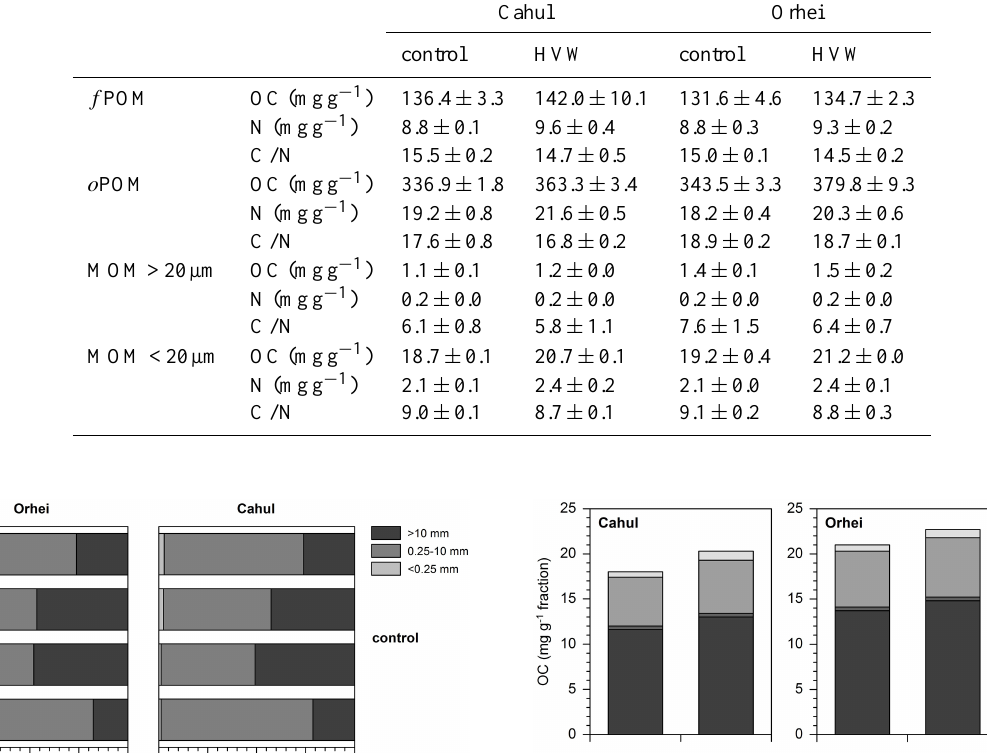
Table 4. Organic carbon (OC) and nitrogen (N) concentrations and C/N ratios of soil fractions ( f POM is free particulate organic matter; o POM is aggregate-occluded particulate organic matter; MOM>20µm is coarse mineral-associated organic matter; MOM <20µm is fine mineral-associated organic matter) in topsoils (0 to 12cm) of control and HVW sites. Cahul